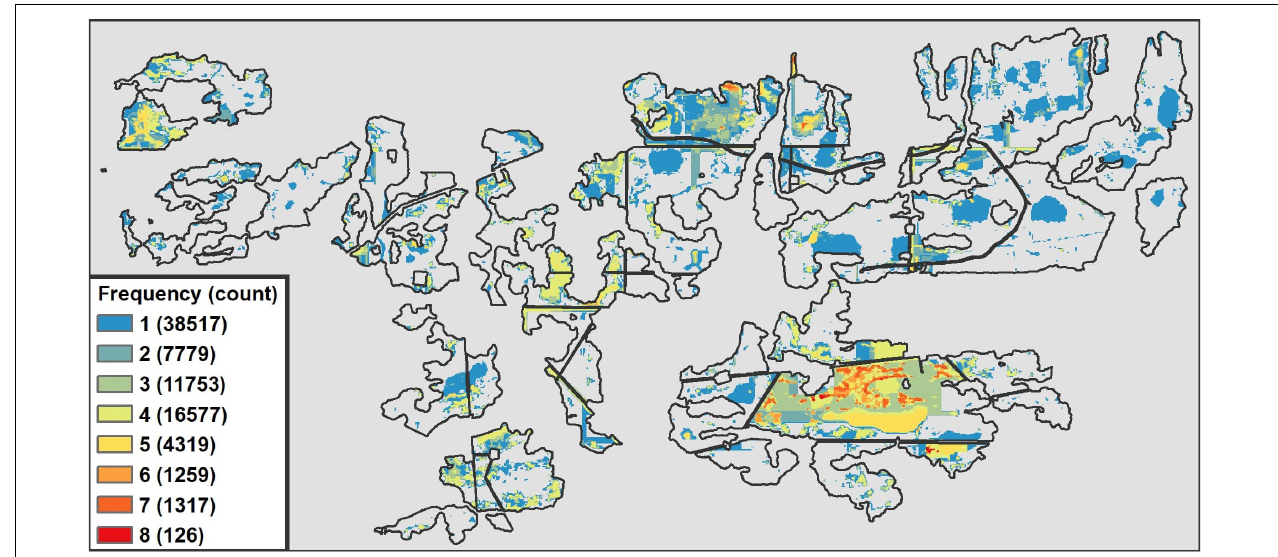
FIGURE 3 | Heatmap showing the frequency of pixel selection across scenarios, including the reference, i.e., pixels coded as “1” were selected in one scenario only, whereas pixels coded as 9 were selected in 9 out of 10 scenarios.